Question: In a single sentence, describe what this figure presents.
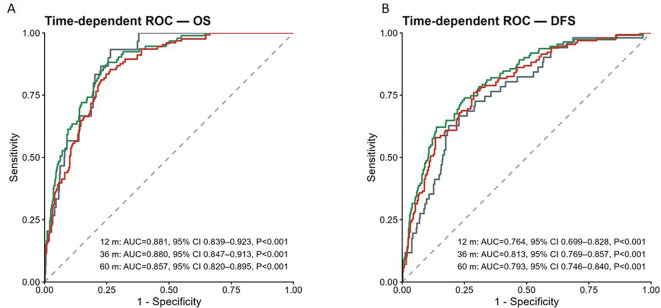
Answer: (A) Time-dependent ROC curves of the final model for predicting 12-, 36-, and 60-month overall survival in the training cohort. (B) Time-dependent ROC curves of the final model for predicting 12-, 36-, and 60-month disease-free survival in the training cohort.